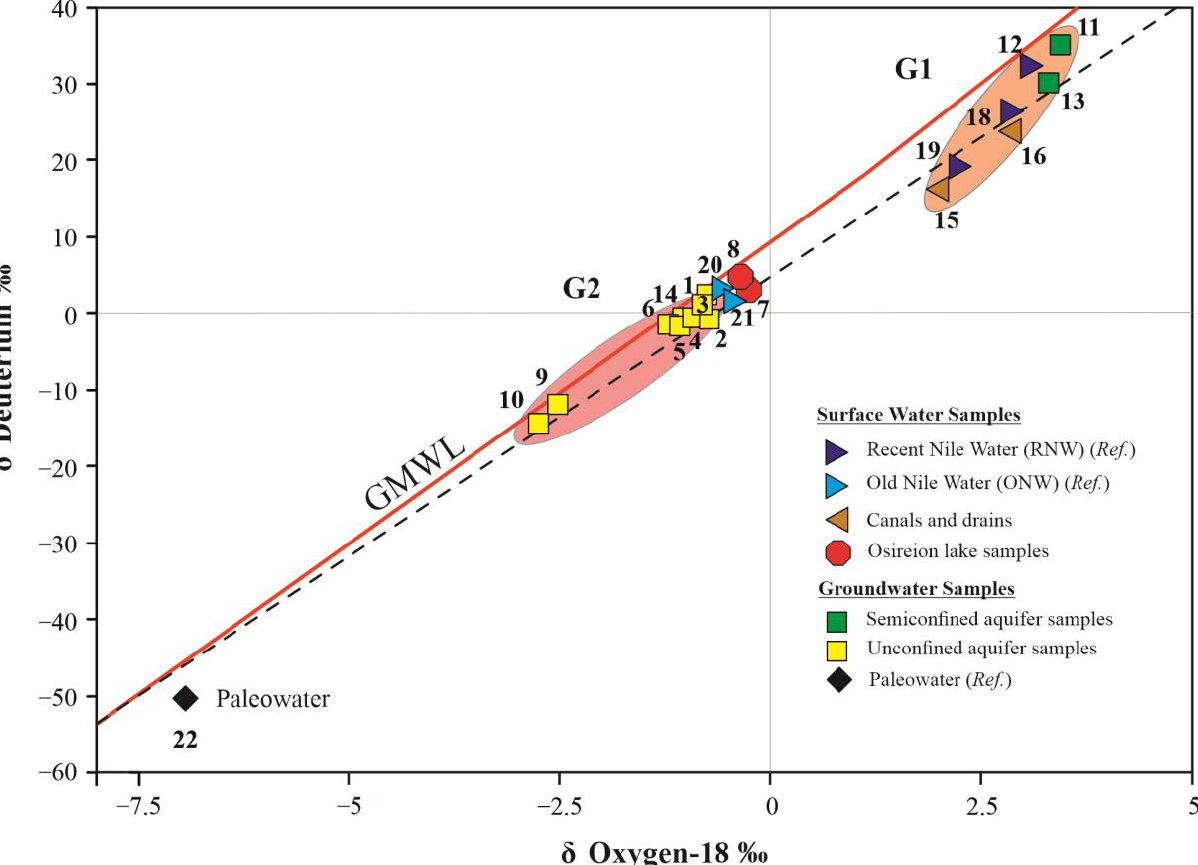
Figure 10. Deuterium and Oxygen-18 of different local groundwater and surface water samples collected from the study area. The long solid line indicates global meteoric water line (GMWL), [72], while the broken line suggests the local meteoric water line (δD = 7.111* δ 18 O + 5.479). Data by previous researchers of groundwater and surface water in the EI-Balyana drain (15), Nag-Hammadi EI-Garbia Channel (16), and Nile River (18 and 19) [73,74], and the old Nile water (20 and 21) [75,76] are also